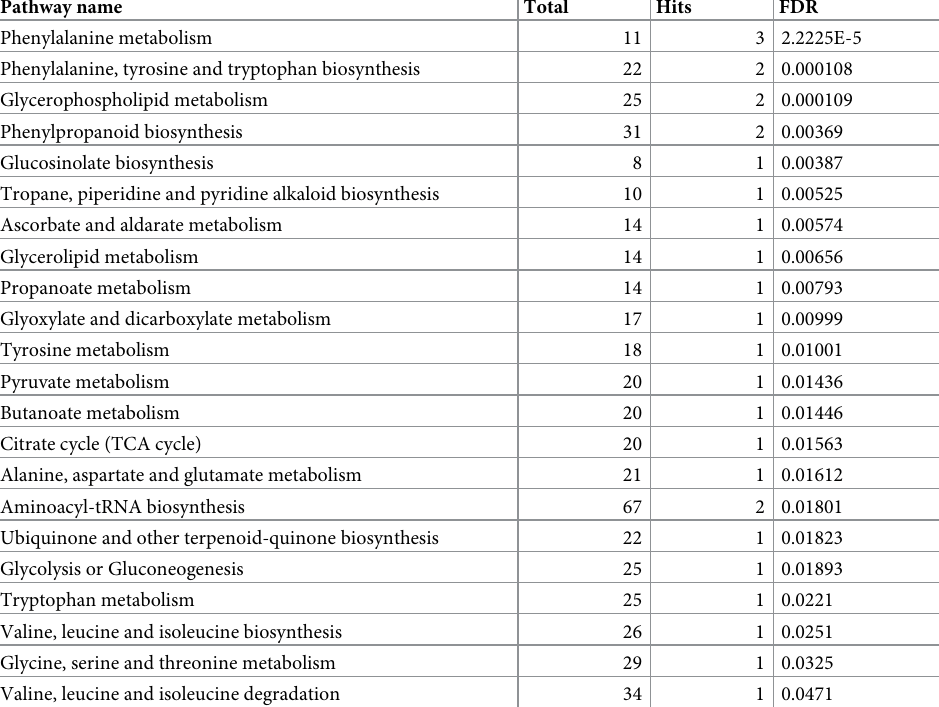
Table 3. Pathway names, total metabolites involved in that pathways, metabolites significantly accumulated in present study (hits), and false discord rate